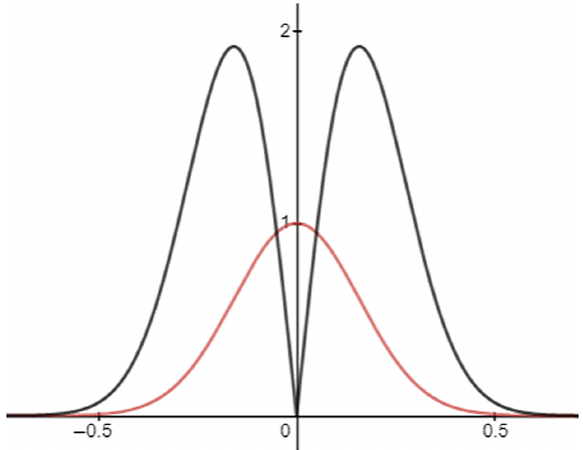
FIG. 7. Hoeffding distribution function. The black curve rep- resents the normalized probability distribution of the variable y = X − μ > 0, P ( y ) = 2 n | y | e − 2 ny 2 , while the red curve repre- sents 1 minus the cumulative probability of such a distribution; that is, the probability that y lies outside the range [0, t ], given by Hoeffding inequality [ 44]. Since for the case y < 0 Hoeffd- ing inequality holds simmetrically and hence P ( y ) = P ( − y ) , the probability that y lies outside the range [ − t , t ] amounts to P ( | y | ≥ (cid:19) (cid:19) − t ∞ − 2 nye − 2 ny 2 dy + 2 nye − 2 ny 2 dy = e − 2 nt 2 . The t , t > 0 ) = −∞ t variance of the black function is var y = 1 /( 2 n ) . We use the vari- the constraint c T ( y ) of the problem given by Eq. (C8) by asserting that it lies inside the interval d expt. − τ((cid:12)) ≤ c T y ≤ d expt. + τ((cid:12)) √ − ln (cid:12) mal table, considering that such an interval amounts to standard